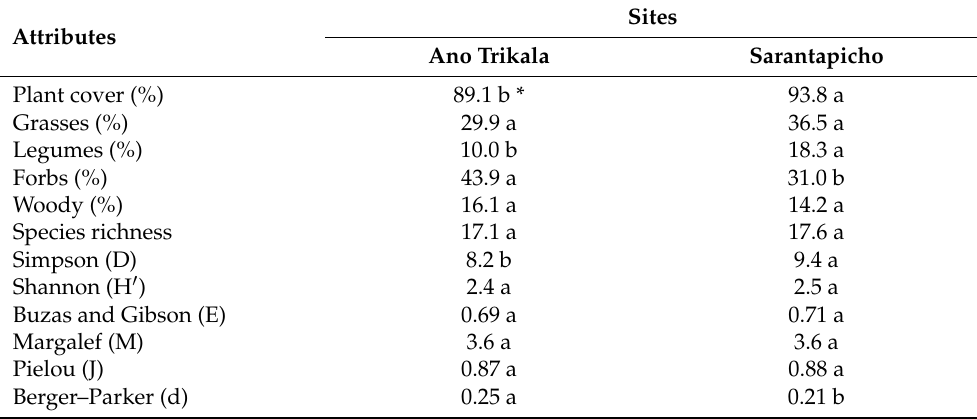
Table 3. Effects of site (across years) on plant cover, functional group composition, and diversity